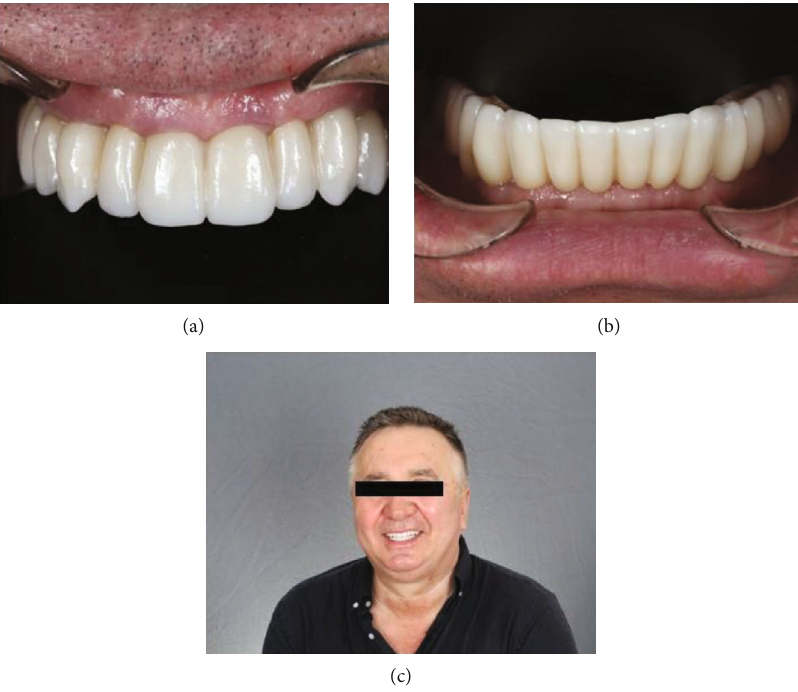
Figure 9: Final look of the prostheses on maxilla (a) and mandible (b). Patient ’ s joyful smile